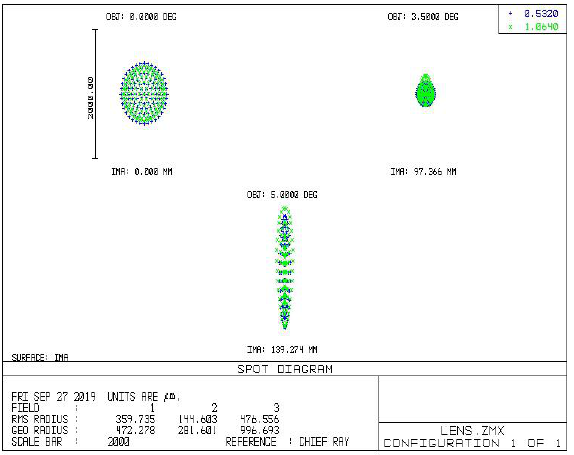
Figure 10. The circuit principle diagram